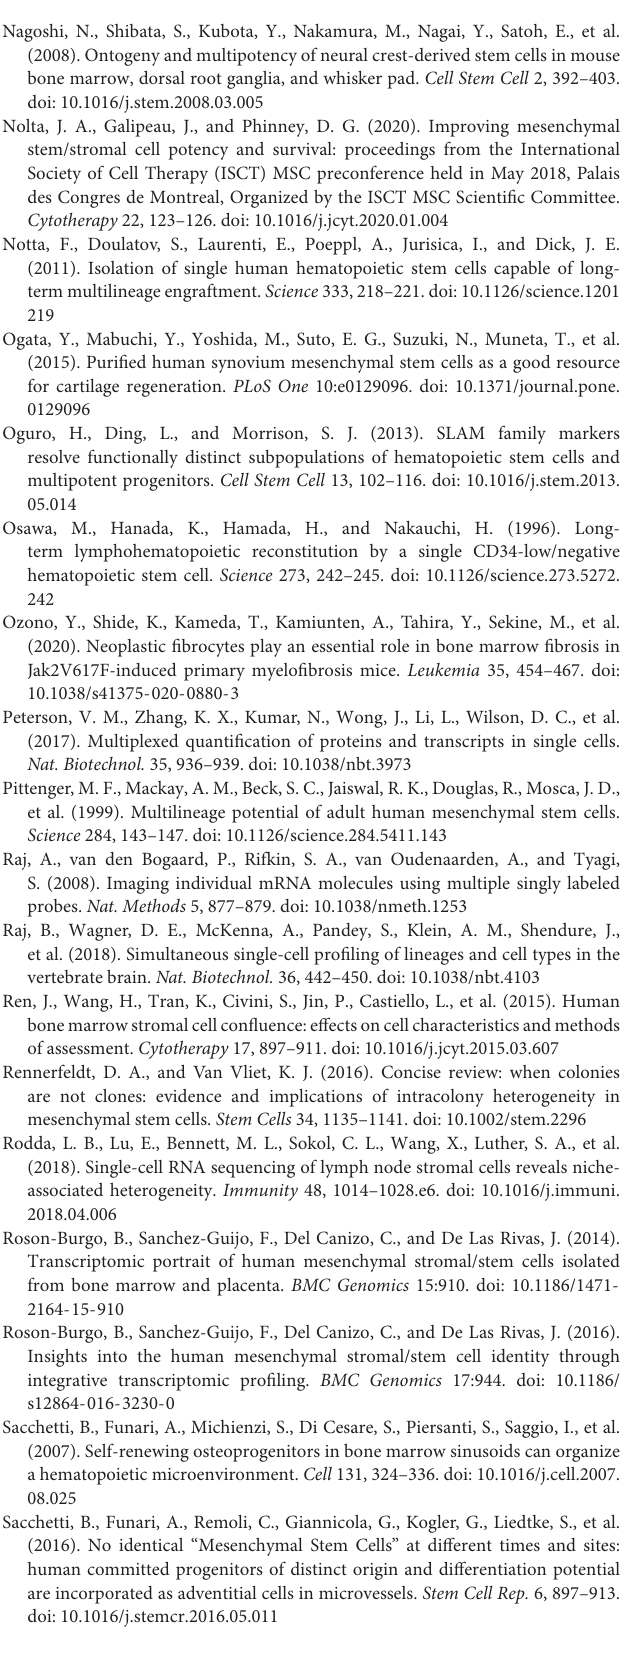
Frontiers in Cell and Developmental Biology |